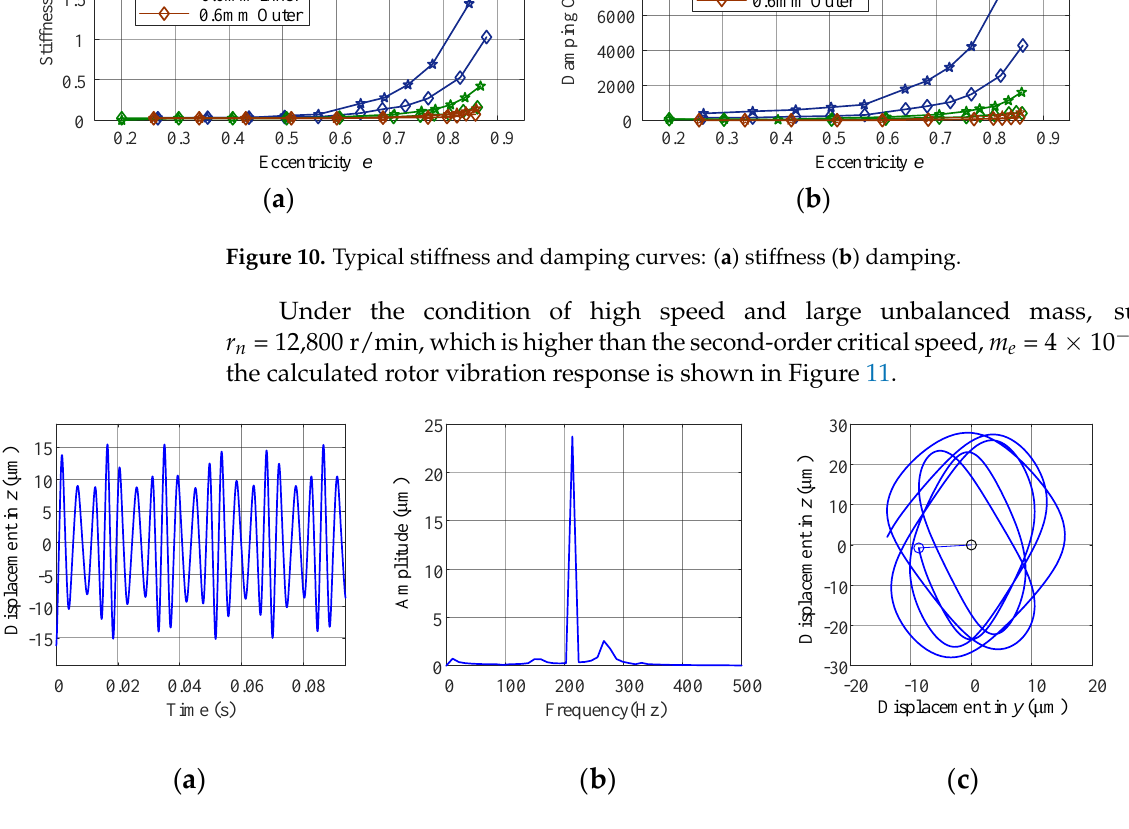
Figure 11. Vibration response under speed of r n = 12,800 r/min and unbalanced mass of m e = 4 × 10 − 4 kg·m. ( a ) time domain response; ( b ) frequency domain response; ( c ) displacement. The unbalanced mass increases, namely m e = 4 × 10 − 3 kg · m. Under the same high speed r n = 12,800 r/min, the vibration response of the rotor system is calculated, as shown in Figure 12.